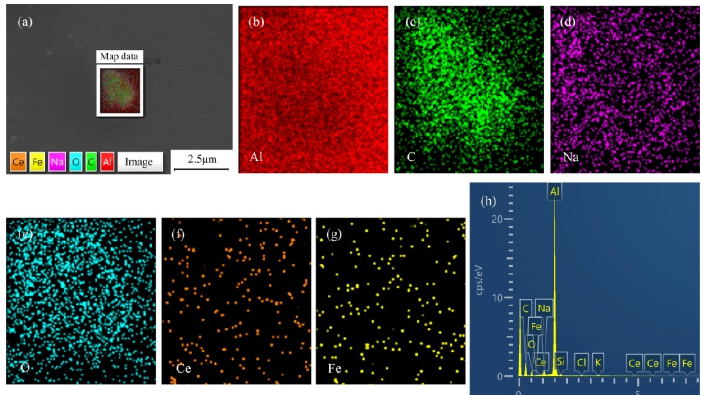
Figure 15. (Ce-Fe) phase in A357 alloy. ( a ) Detecting position, ( b ) Al element, ( c ) C element, ( d ) O element, ( e ) Ce element, ( f ) Ce element, ( g ) Fe element and ( h ) EDS analysis.